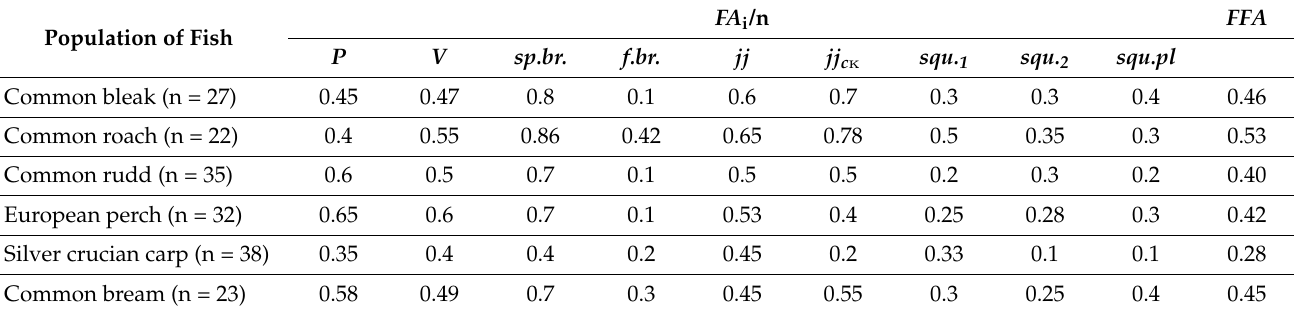
Table 5. The FFA for each studied fish population in the Ustya River at sampling site No. 3 ( p ≤ 0.05).